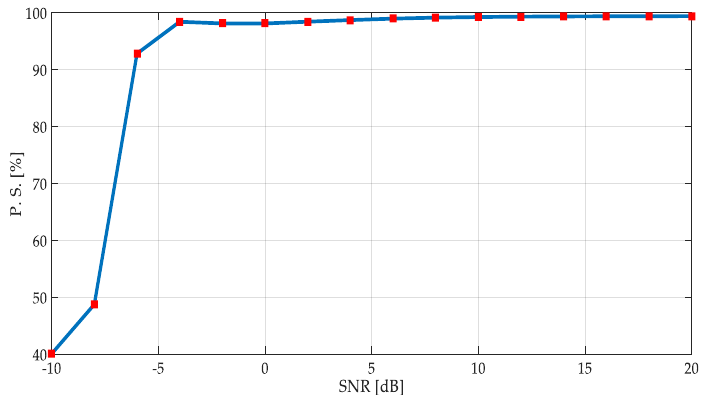
Figure 16. Percentage of success of the first methodology on simulated signals.